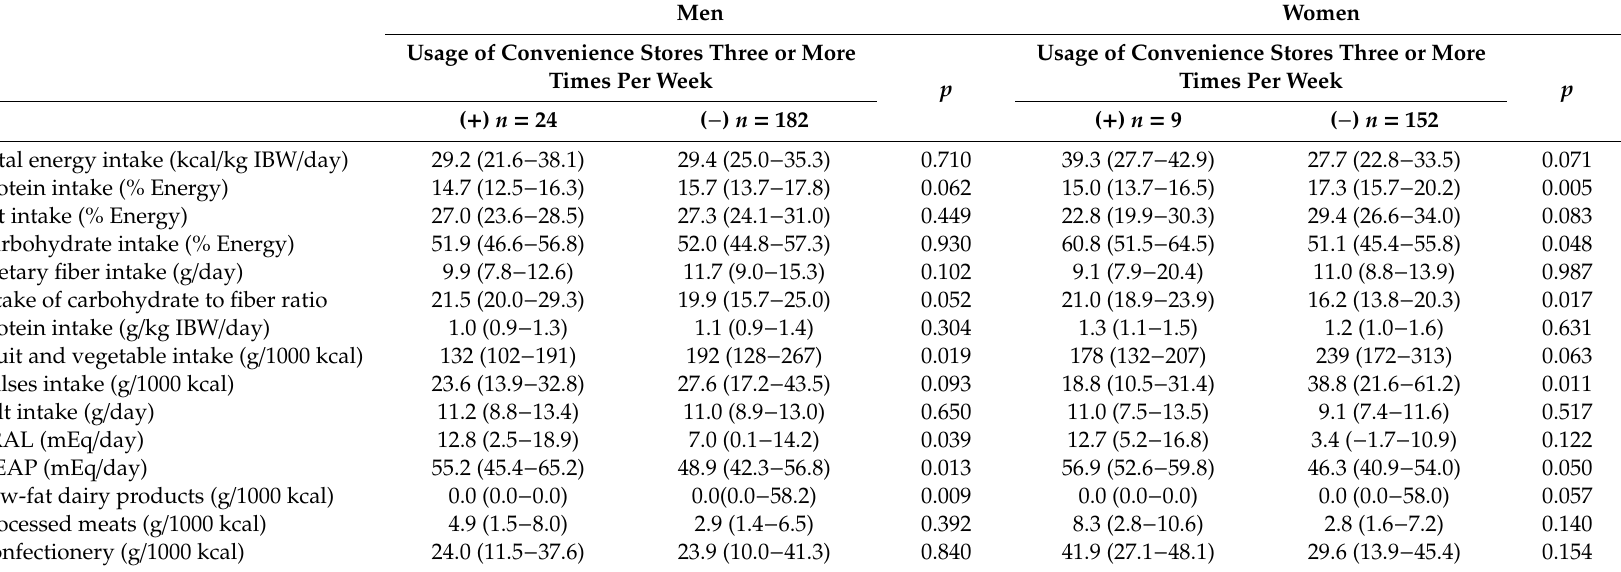
Table 2. Dietary intake of study